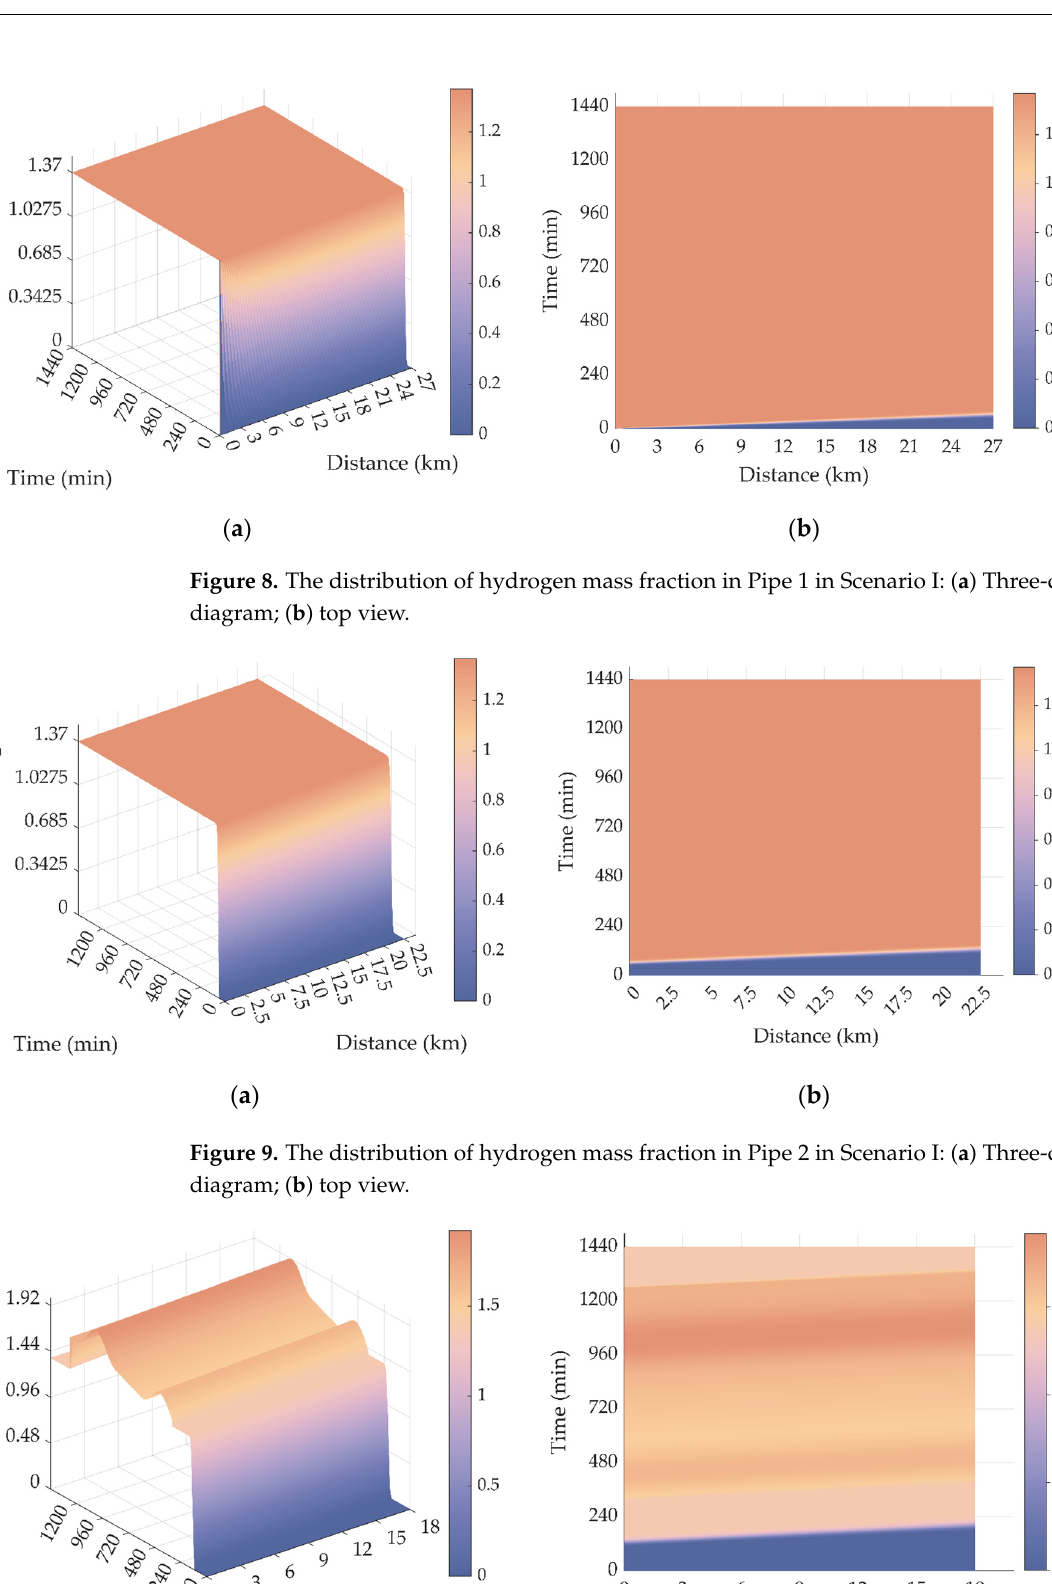
Figure 7. Renewable power output for hydrogen production in Scenario I. According to the dynamic simulation results, the changes of hydrogen concentration in each pipeline are shown in Figures 8–13.